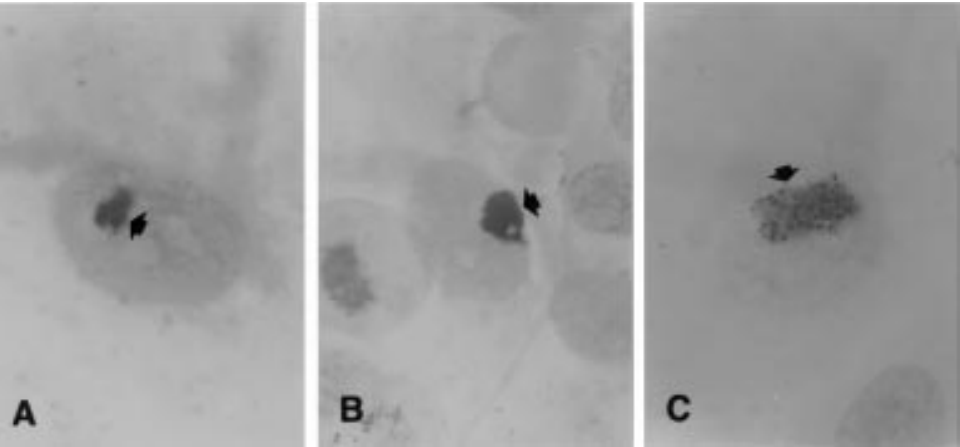
Fig. 3. Immunocytochemical staining of BrdU (blue colour) incorporated in DNA.A – stained developing micronuclei and unstained macronuclei. B – micronuclei in the late phase of the development were stained, while the macronuclei ghosts were unstained. C – BrdU mark dilution in the micronucleus 72 h after 1 h pulse labelling. Arrows point to the micronuclei. DNA was counterstained with Feulgen procedure. Obj. 90 (cid:2) , oc. 7 (cid:2)